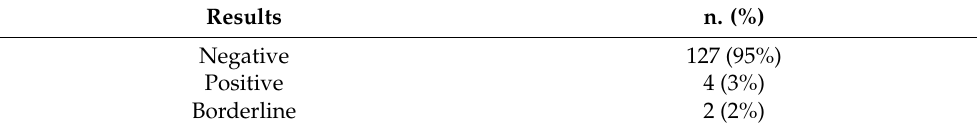
Table 2. Seroprevalence of